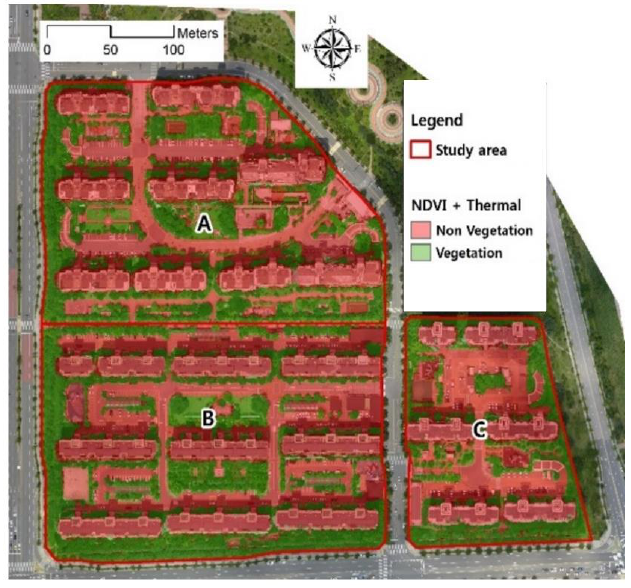
Figure 16. Vegetation map classified by combining NDVI ad thermal infrared image.